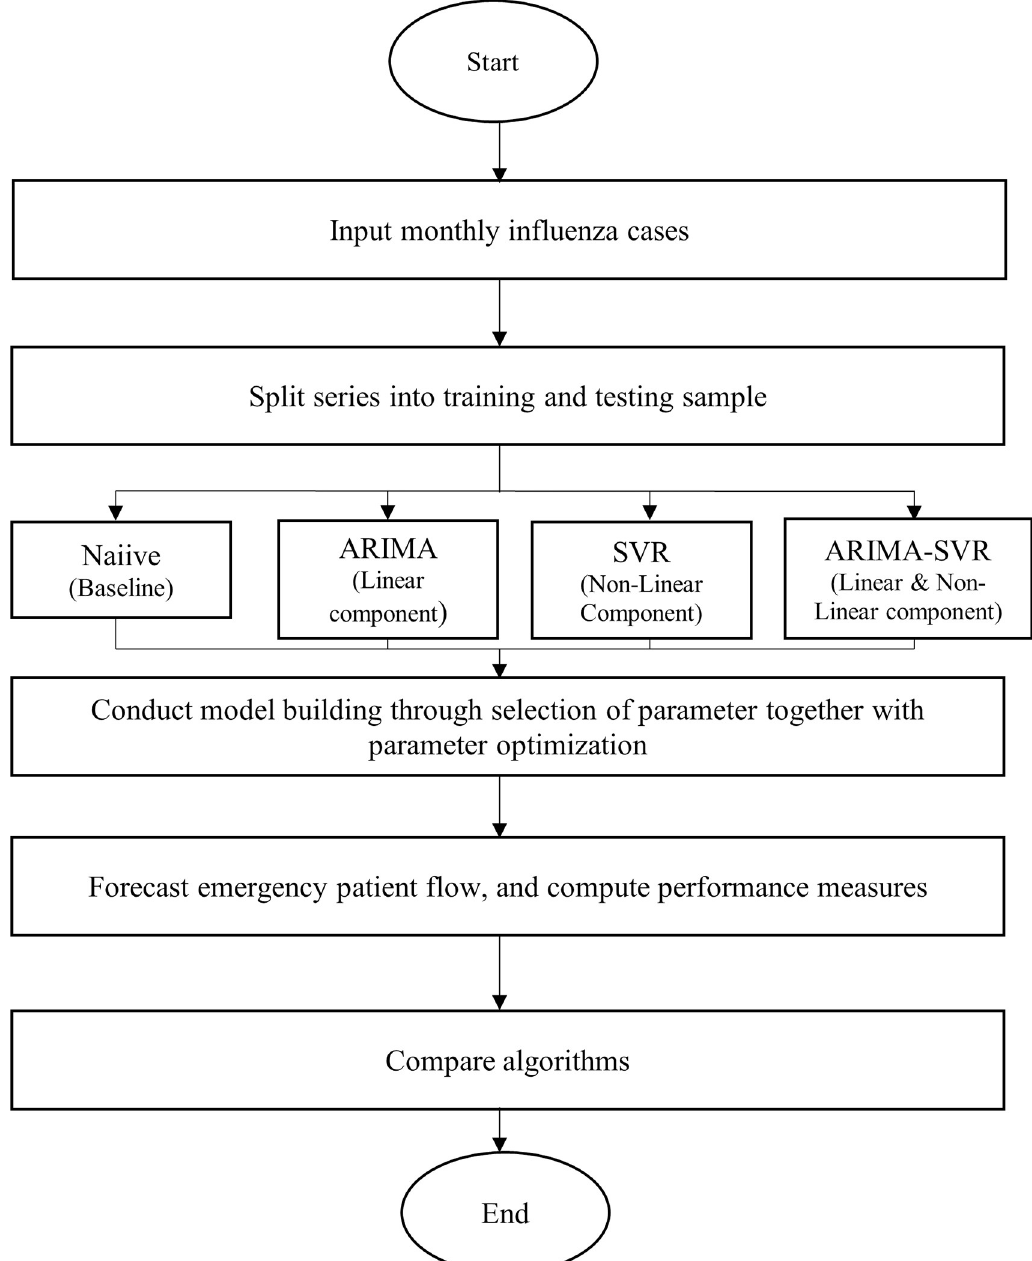
Fig 3. Procedure for development and comparing models in forecasting monthly influenza